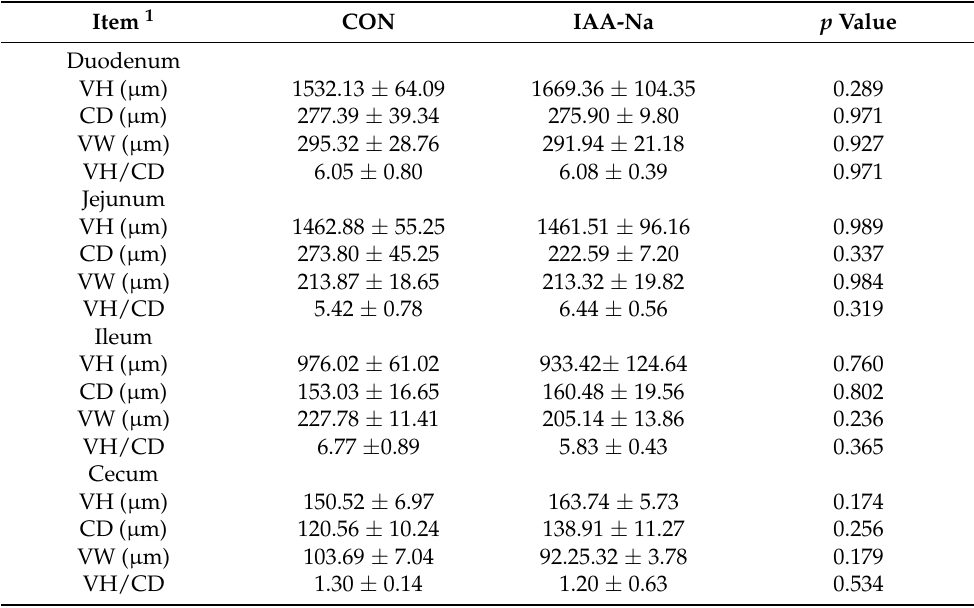
Table 6. Effects of dietary IAA-Na supplementation on the intestinal morphology and structure